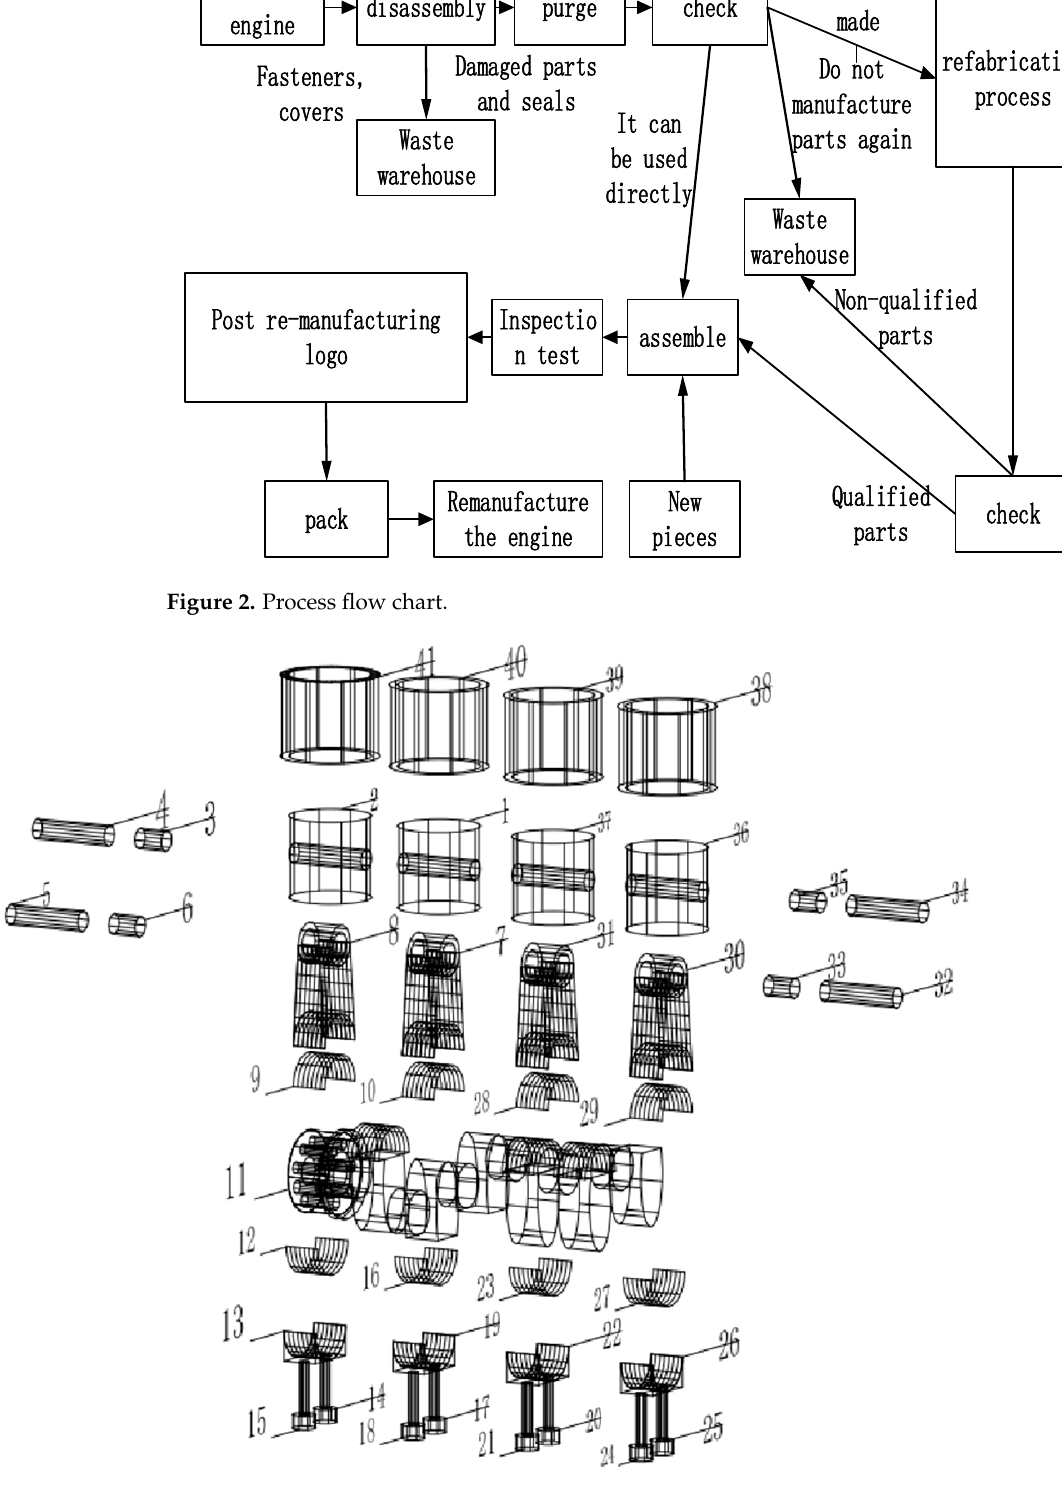
Figure 3. Three-dimensional structural model.